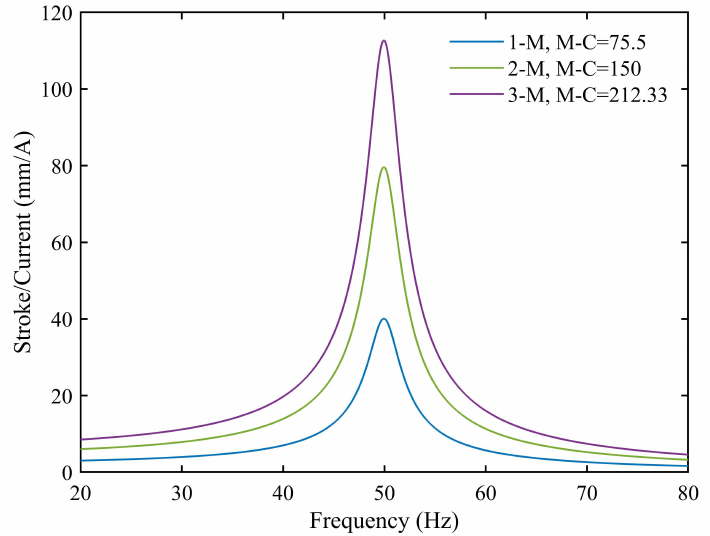
Figure 20. Stroke-to-current ratio of the proposed TMM-LOA.